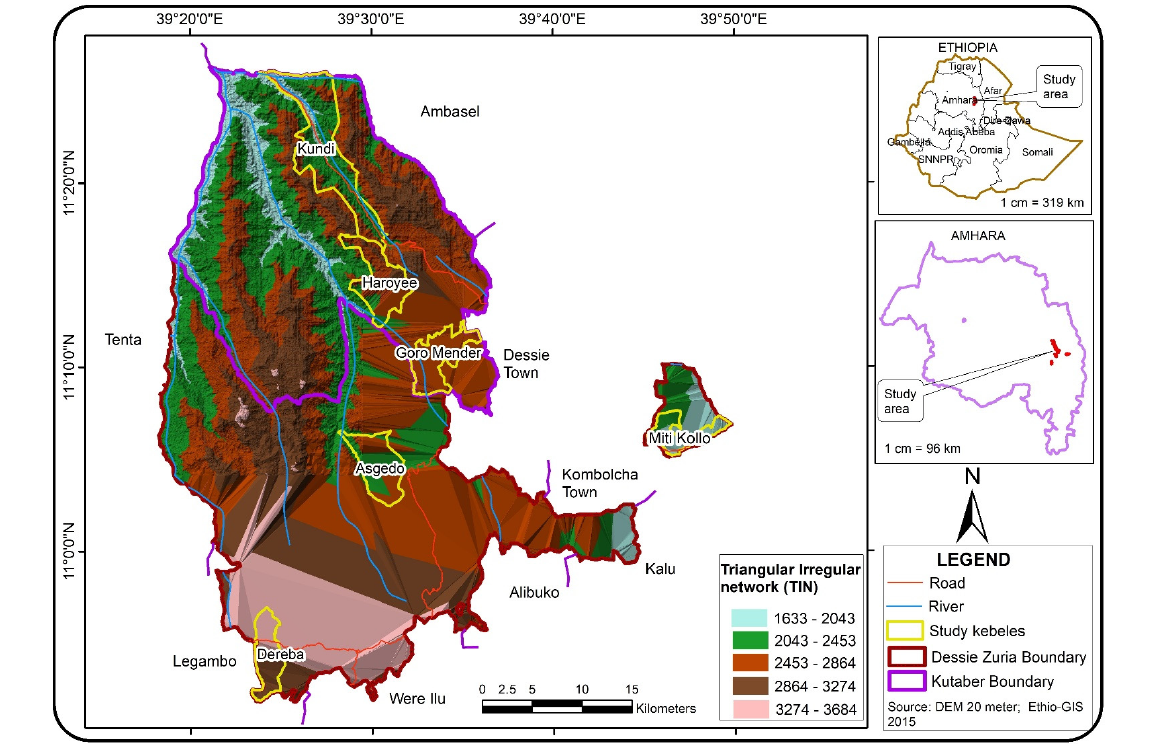
Figure 1. Study area